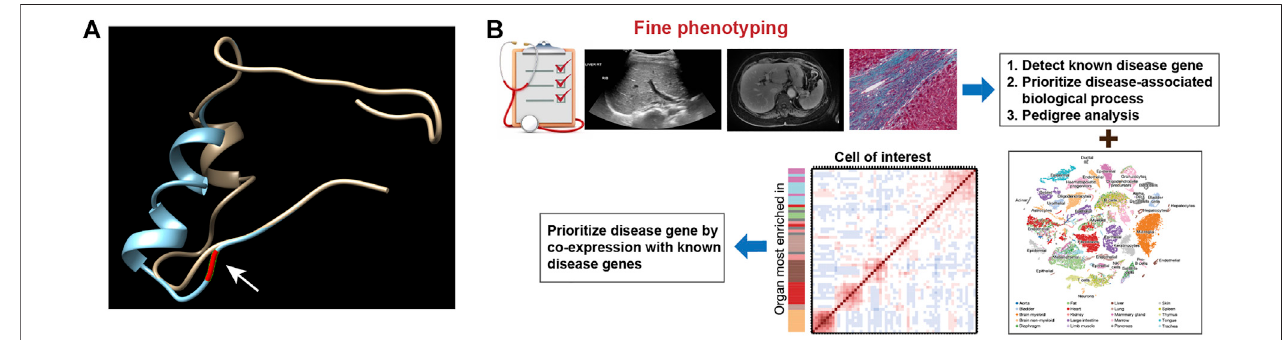
FIGURE 4 | (A) Prediction of the conformation of CRB3 protein. The yellow chain shows the wild-type protein, and the blue chain shows the mutated protein. Residue114ispointedbyarrowandhighlightedinredontheproteinbackbone. (B)